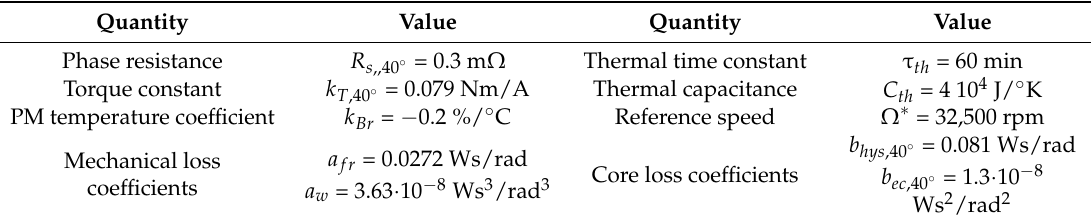
Table 3. Parameters of the flywheel system model.